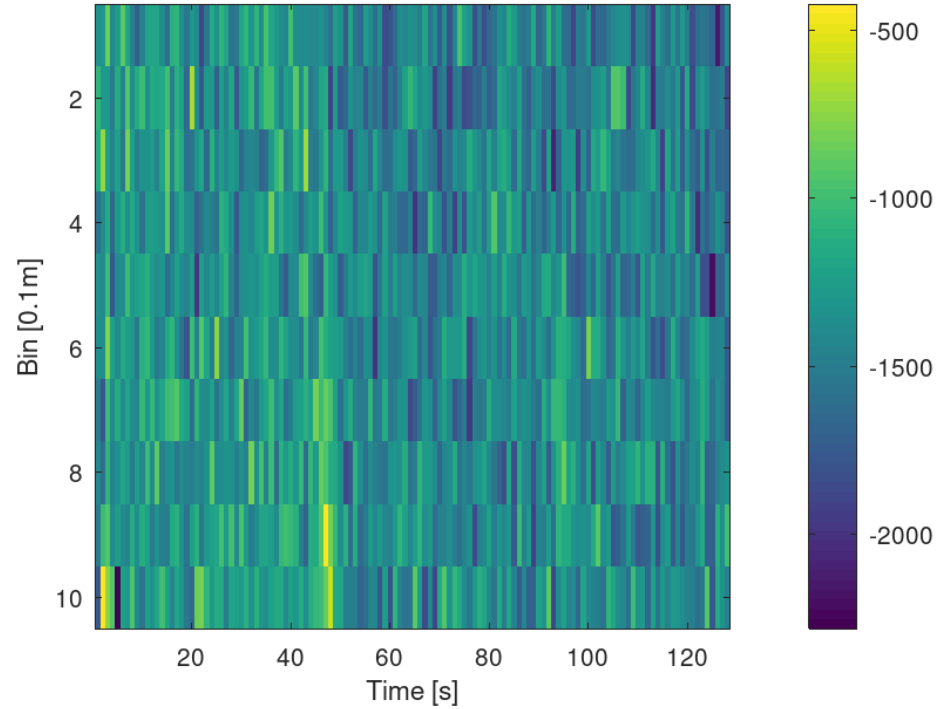
Figure A5. Waterfall plot of filtered inflow x–velocity for Aquadopp 1 in mm/s. Bin size is 0.1